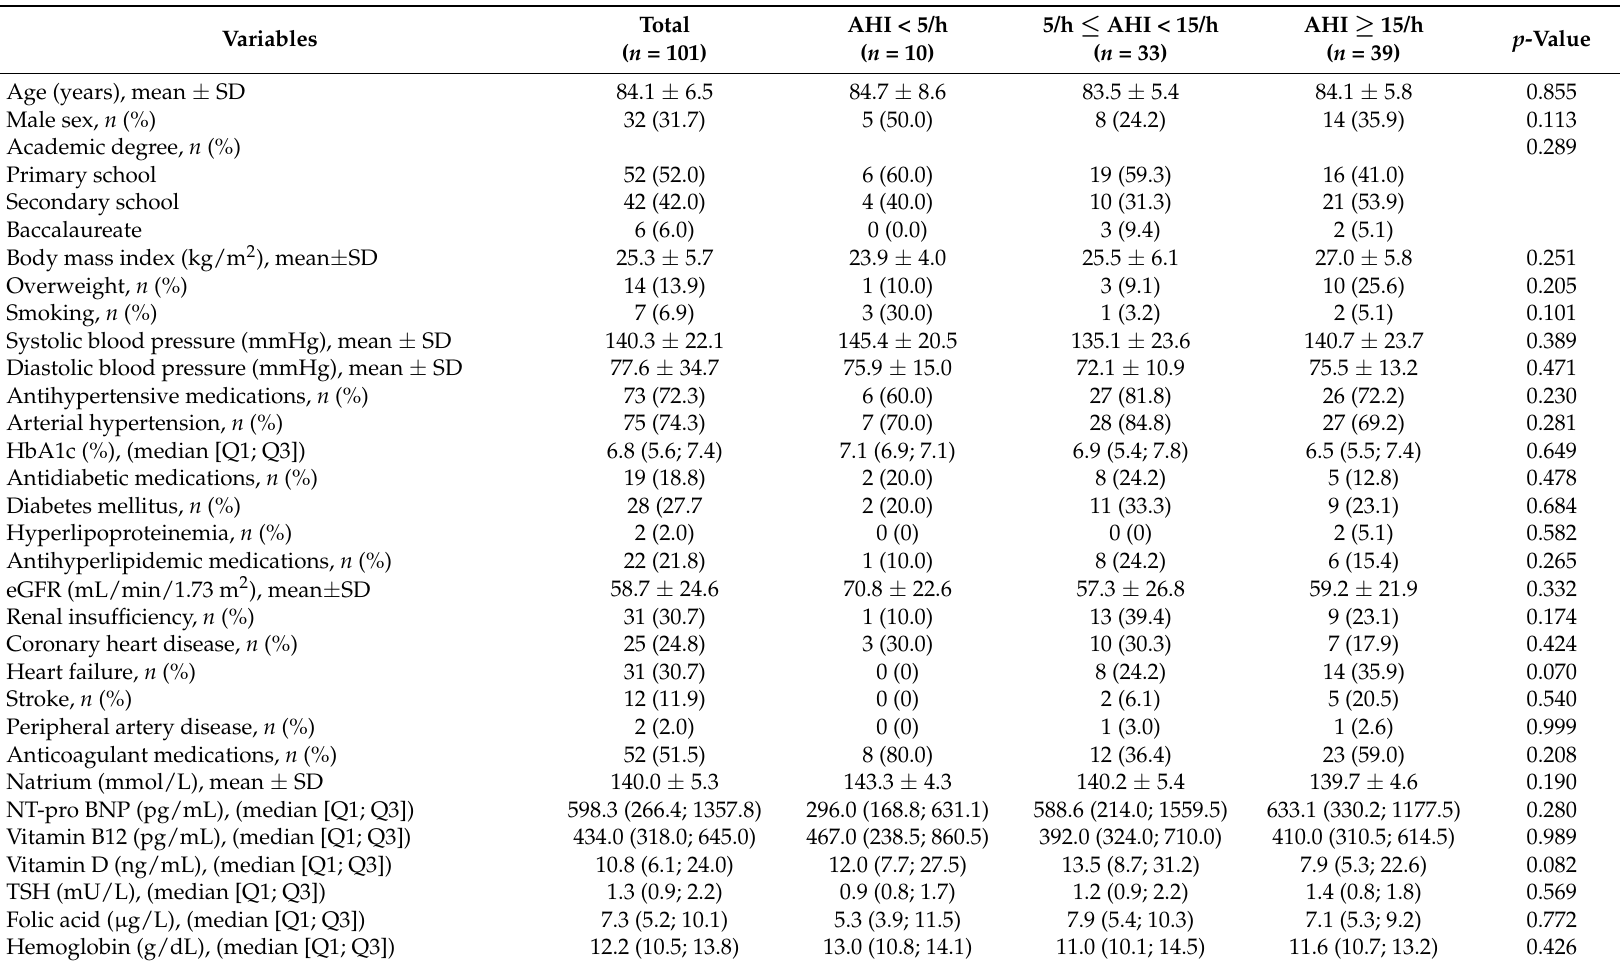
Table 1. Demographic and clinical characteristics of the study cohort also split by AHI